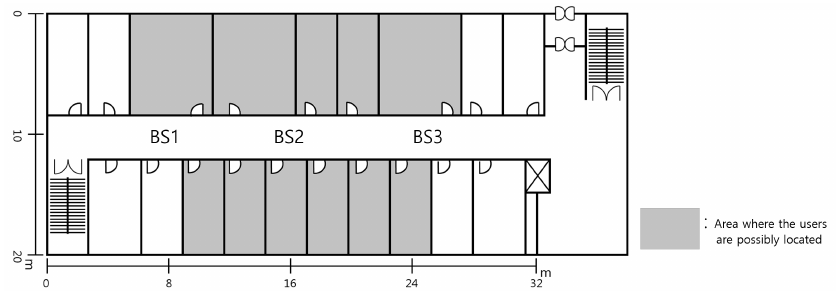
Figure 6. User area (shaded) and BS location in non-line-of-sight (NLoS) environment.